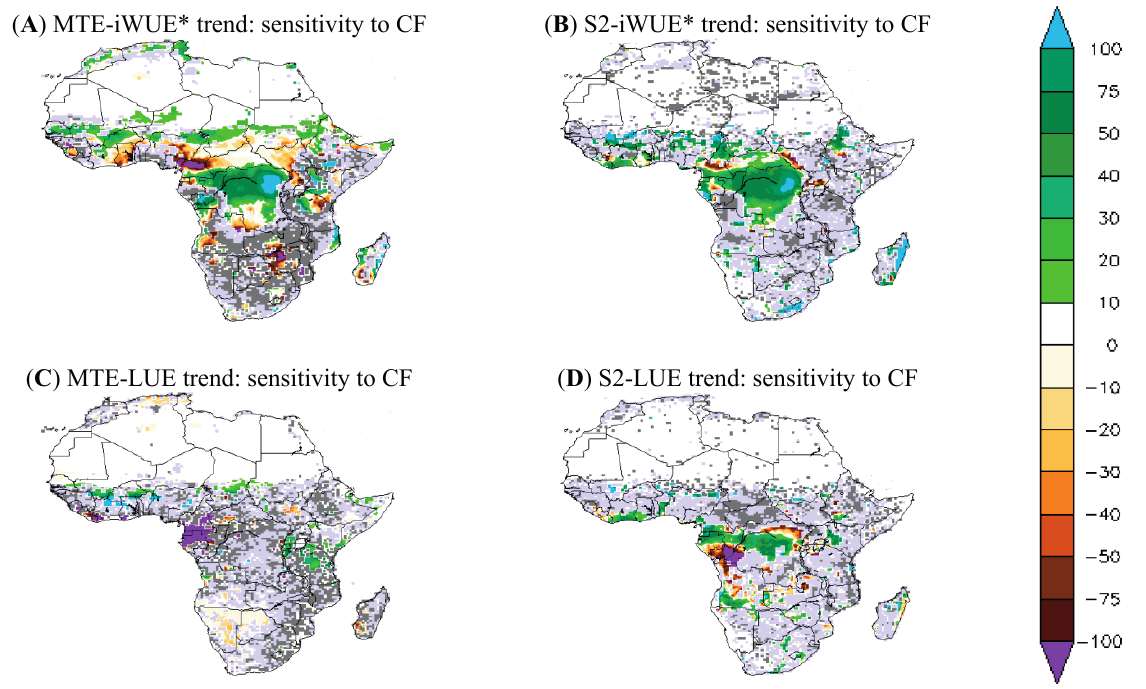
Figure 7. Systematic error (sensitivity) of iWUE* trends and LUE trends to the choice of climate forcing (CF). Each plot shows the trend difference between a simulation with WFDEI CF minus one with WFD CF. ( A ) Difference between MTE-iWUE* trends calculated with WFDEI and WFD VPD; ( B ) Difference between iWUE* trends of ORCHIDEE 2-layers simulations; ( C ) MTE-LUE calculated with WFDEI and WFD APAR; and ( D ) Difference between LUE trends of ORCHIDEE 2-layers